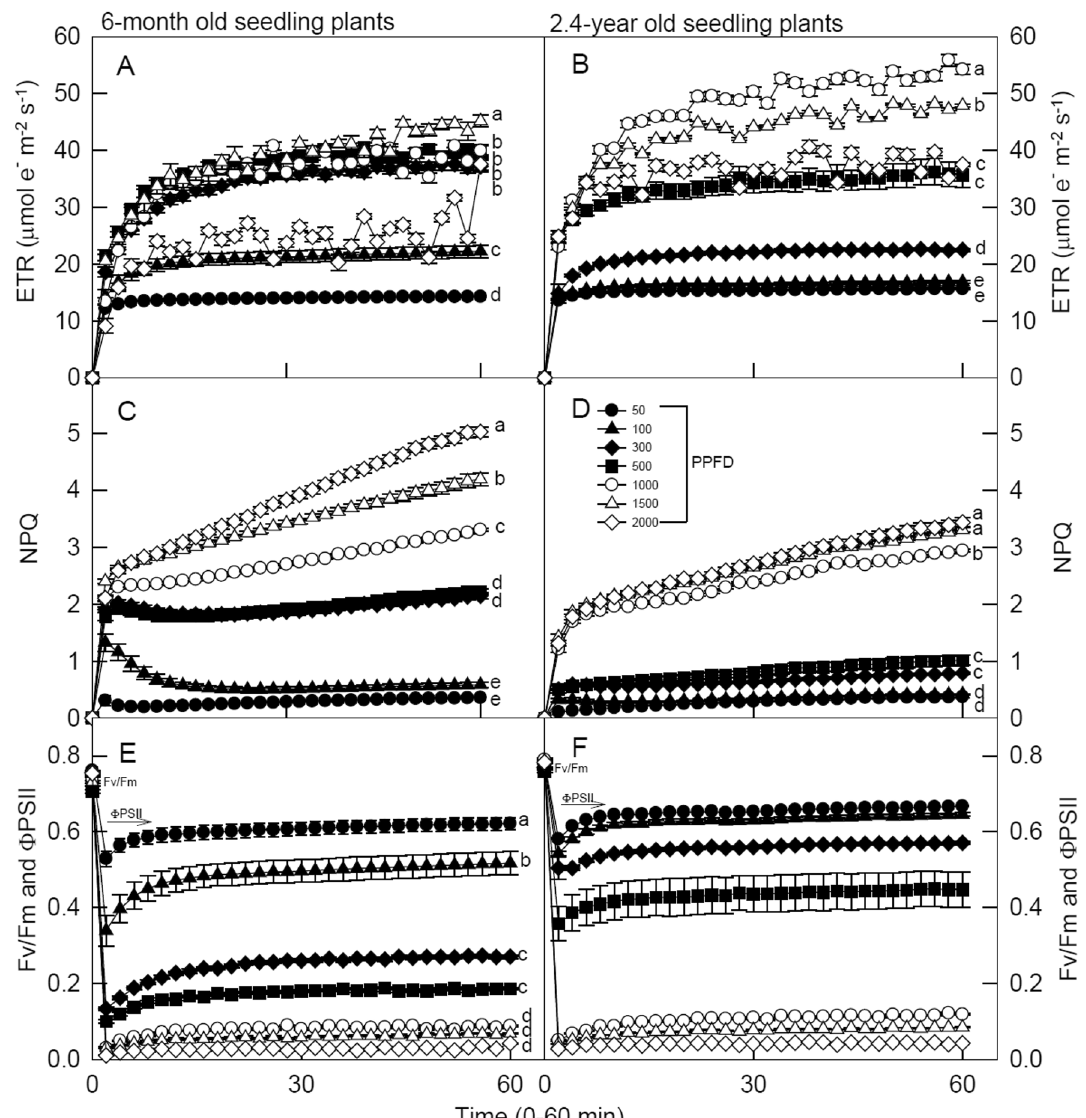
Fig. 1 Time‑course changes in electron transport rate (ETR), non‑photochemical quenching (NPQ), and both Fv/Fm (unlit) and PSII efficiency ( Ф PSII, 2 ~ 60 min) for 6‑month (panels A , C , and E ) and 2.4‑year (panels B , D , and F ) old seedlings of Mahonia oiwakensis . During the 60‑min of light induction, the measurements were made at 25 °C under 50, 100, 300, 500, 1,000, 1,500, and 2,000 μmol m − 2 s. − 1 photosynthetic photon flux density (PPFD). Vertical bars indicate standard errors, and each point represents the mean of 5 leaves. Different letters indicate significant differences in the Tukey’s HSD analyses at seven light intensity treatments ( p <